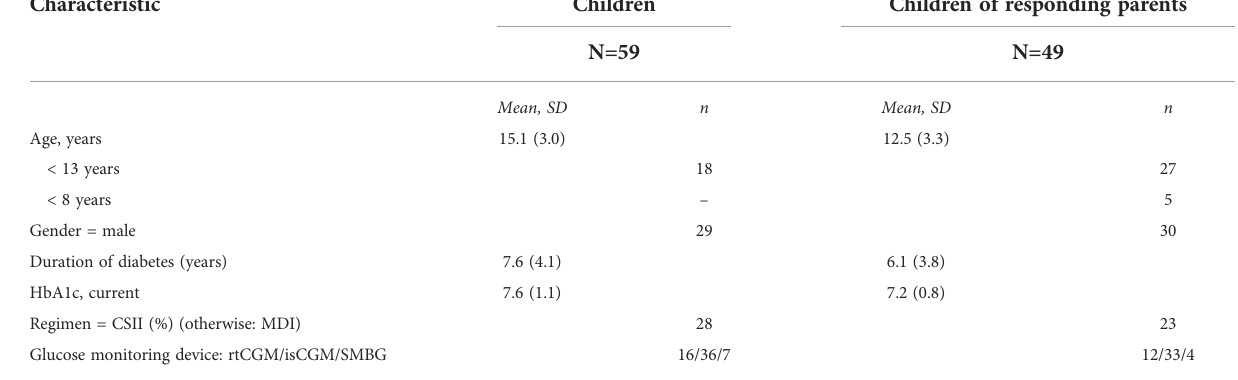
TABLE 1 Demographic and diabetes speci fi c characteristics of the study participants.